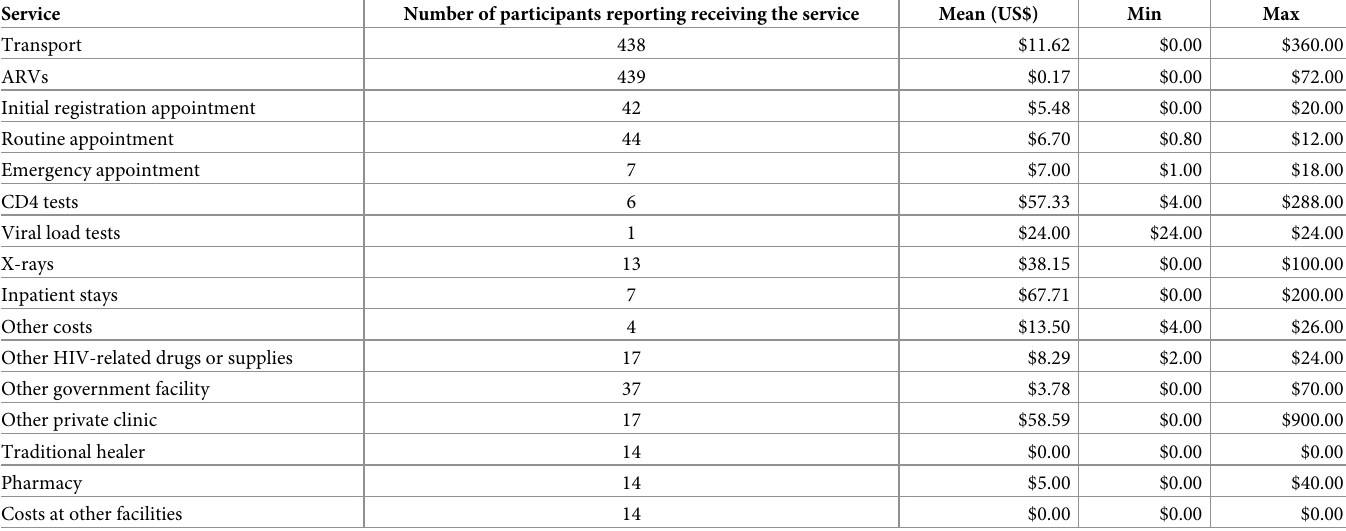
Table 4. Estimated participant annual costs for receiving ART services among participants who incurred cost associated with that service or consumable, Zimbabwe 2017 �